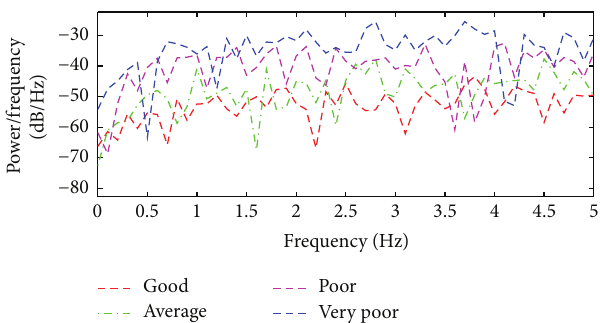
Figure 4: PSD for different road classes excitation.